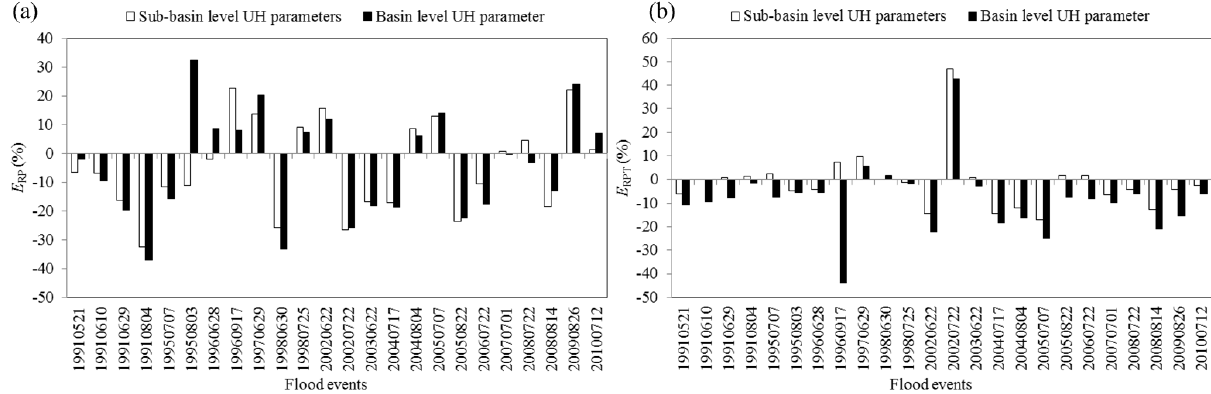
Figure 9. Comparisons between sub-basin level and basin level UH parameter cases for relative peak discharge error (a) and relative peak time error (b)